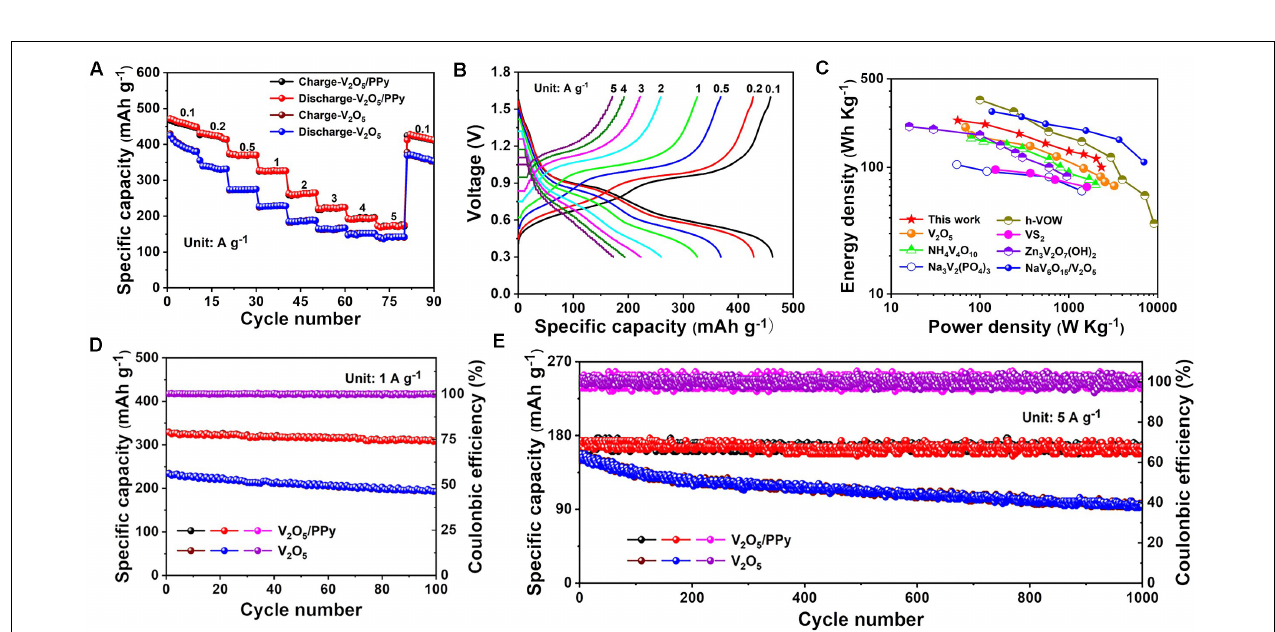
FIGURE 1 | (A) Schematic illustrating the preparation of V 2 O 5 /PPy composite. Characterizations of the V 2 O 5 /PPy composite. (B) SEM image and (C) Corresponding elemental mappings, (D) TEM image, (E) XRD patterns, (F) XPS survey spectrum, and (G) V 2p spectrum with fitting showing mixed valence of V after PPy coating.